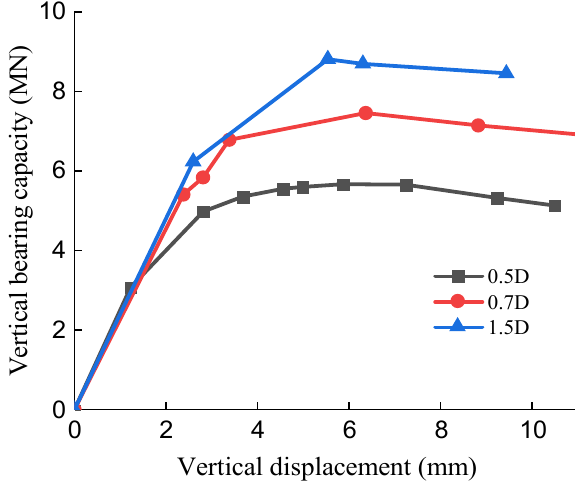
Figure 17. The influence of socket depth.